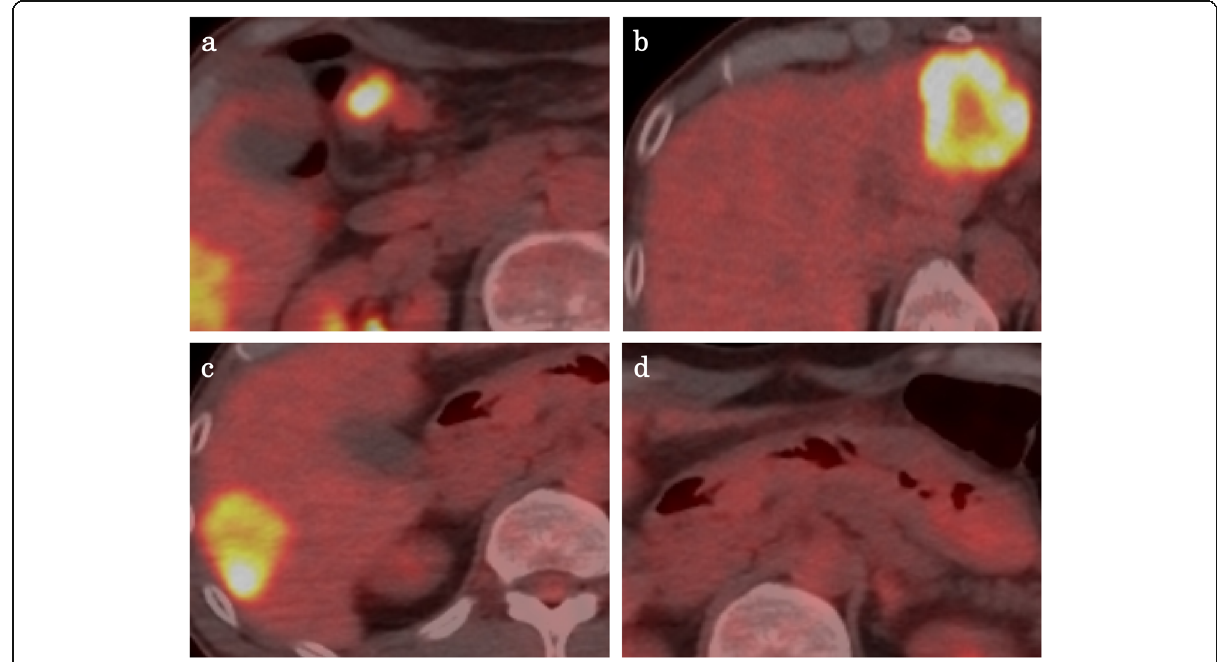
Fig. 4 FDG PET/CT findings before chemotherapy. FDG PET/CT findings showed 18F-FDG uptake by the transverse colon cancer ( a , SUVmax of 14.4), multiple liver metastasis in segment 2/3 ( b , no SUVmax measurement) and in segment 6 ( c , SUVmax of 11.3), but there was no uptake in the gastric body ( d